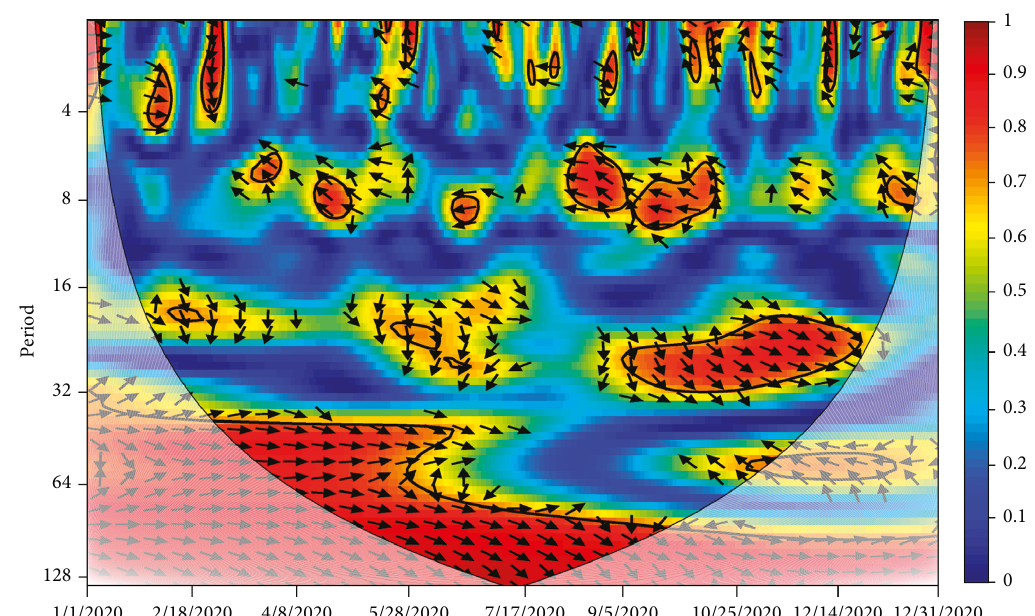
Figure 8: The wavelet coherency between illiquidity and IDEMV (pandemic period). Note: this figure reports the wavelet coherency between illiquidity and IDEMV during pandemic period. The black contour represents the regions in which the spectrum is significant at the 5% level against red noise. The cone of influence denoted as COI is designated by the lighter shade which delineates the high power regions. Time and scale (days) are represented on the horizontal and vertical axes, respectively. Arrows pointed to the right (resp. left) signify that the variables are in phase (out of phase). If arrows move to the right and up (resp. down), the first variable is the driver (resp. follower). By contrast, if arrows move to the left and up (down), the second variable is leading (resp. lagging).